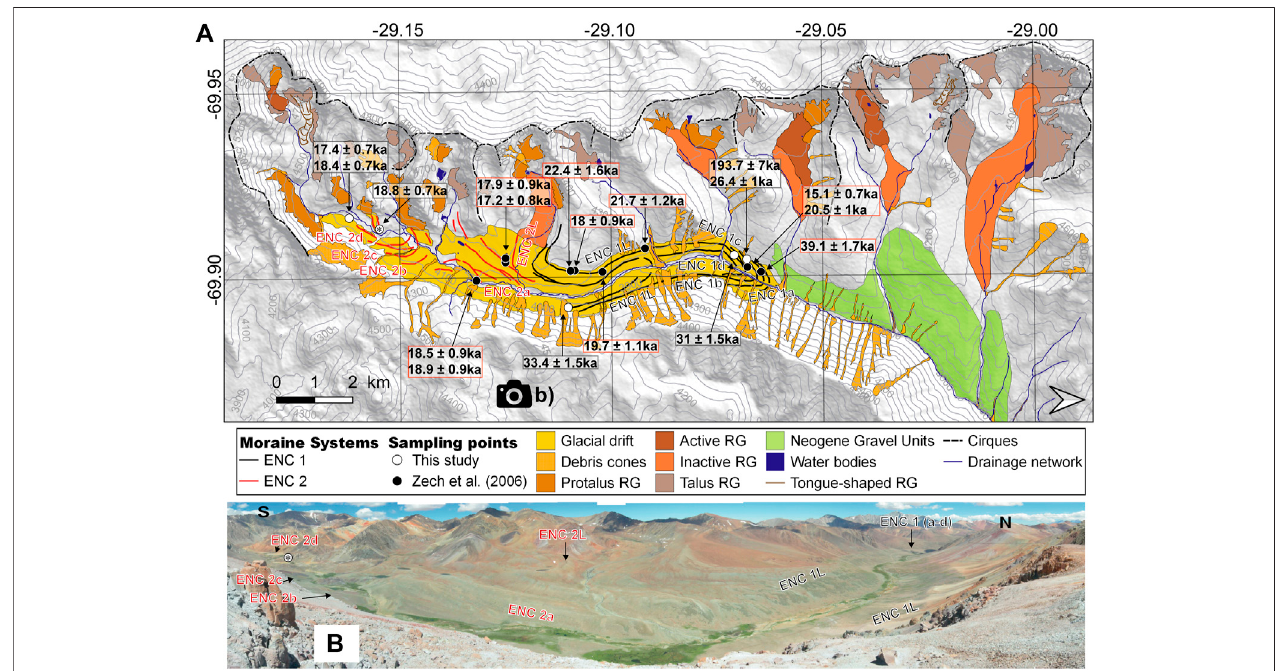
FIGURE 2 | (A) Geomorphological map showing 10 Be exposure ages ofthis study (white solid circles) and recalculated from Zech et al. (2006) (black solid circles). The sample from the ice-molded bedrock surface is highlighted within the sampling points of fi gure A with an *. RG: rock glacier. (B) Photograph toward the west taken from the east slope of the ERV showing the distribution of moraine ridges mapped in panel